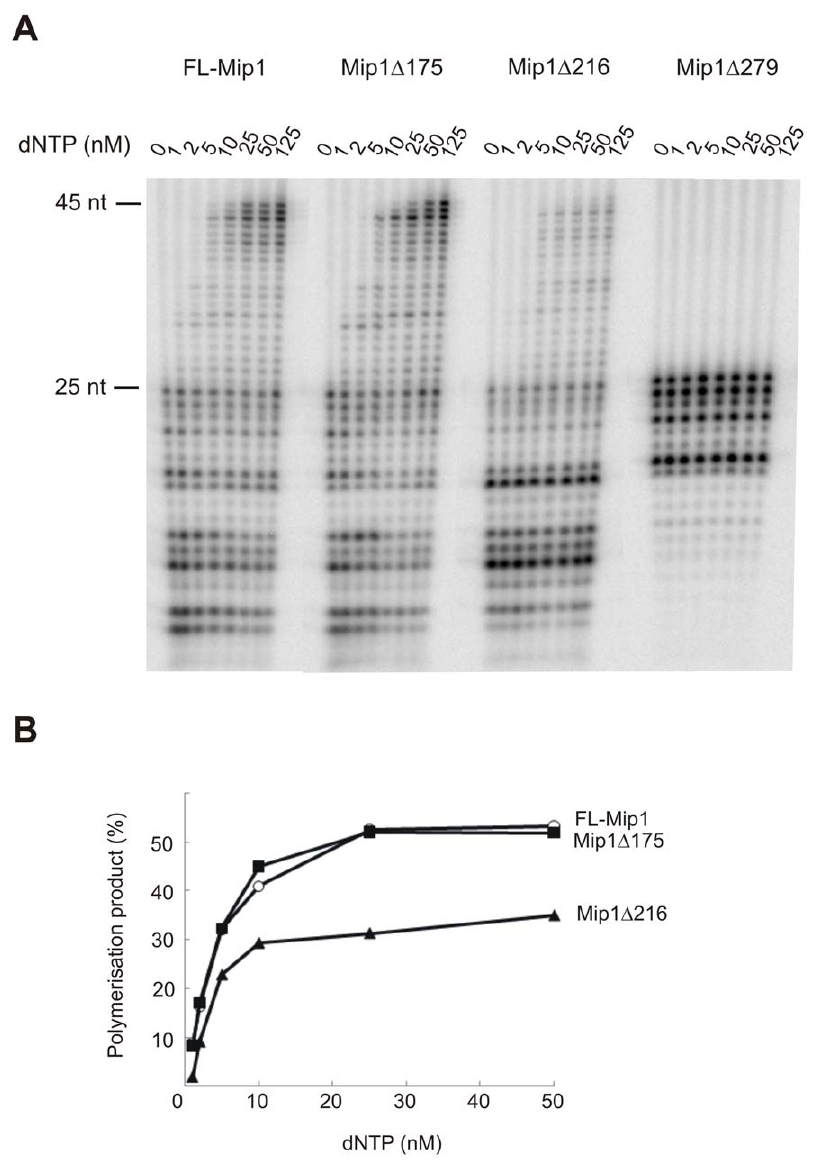
Figure 6. Polymerase/exonuclease balance of Mip1 and C-terminal deletion mutants. The balance between polymerase and exonuclease activities was assayed on a 45 nt template primed with a radiolabeled 25 nt primer. 4 nM DNA polymerase and 10 nM substrate were incubated for 5 min at 30 u C in the presence of indicated concentrations of dNTP. Reactions were stopped with an equal volume of 80% formamide, 25 mM EDTA. A. Reaction products were resolved on 8% urea polyacrylamide gel. Positions of the 25 nt primer and 45 nt reaction product are indicated. B. The percentage of the polymerization products out of total reaction products were plotted against dNTP concentration. FL-Mip1 – empty circle, Mip1 D 175 –filled square, Mip1 D 216 – filled